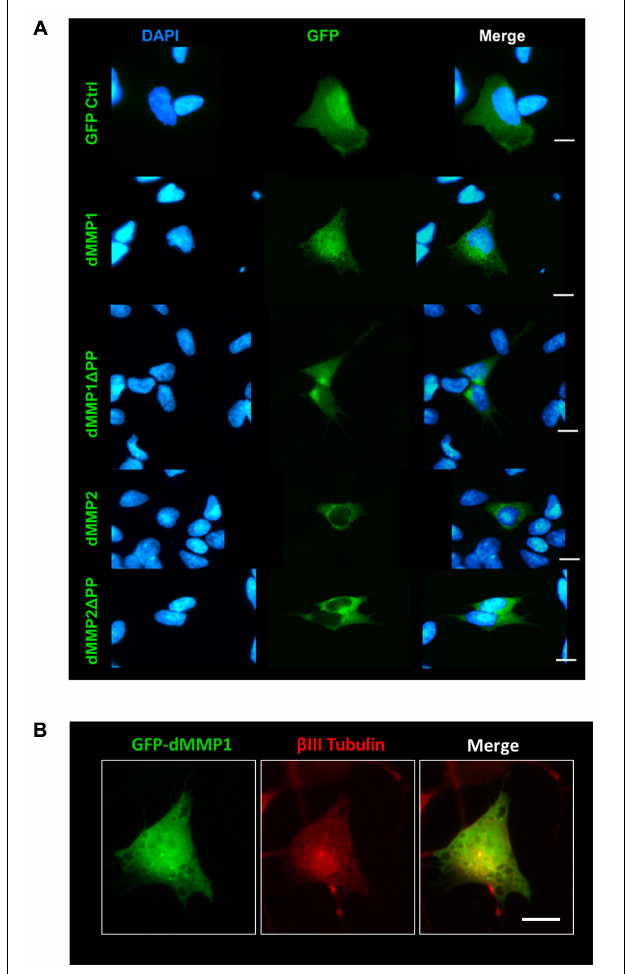
FIGURE 3 | GFP-dMMP localization in neuronal cells. (A) Transfection of SH-SY5Y cells with GFP-dMMPs and GFP alone, using Fugene 6, and localization patterns of GFP at 24 h post-transfection. GFP Control localized to the nucleus and cytoplasm whereas GFP-dMMP constructs localized differentially in SH-SY5Y neuroblastoma cells. Shown in blue is DAPI nuclear stain. Shown in green are the various GFP constructs compared to GFP control. (B) An enlarged image of GFP-dMMP1 (green) co-localization with β III Tubulin (red). Scale bar = 10 µ